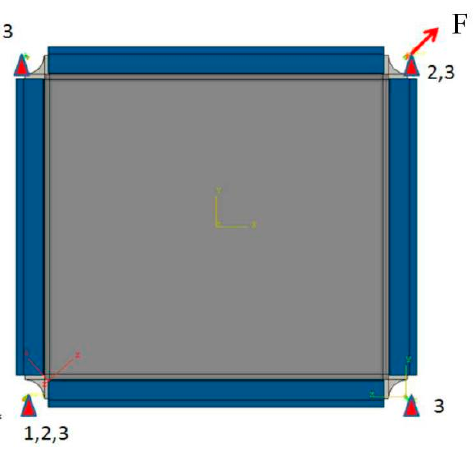
Figure 11. Boundary condition of in-plane shear test.